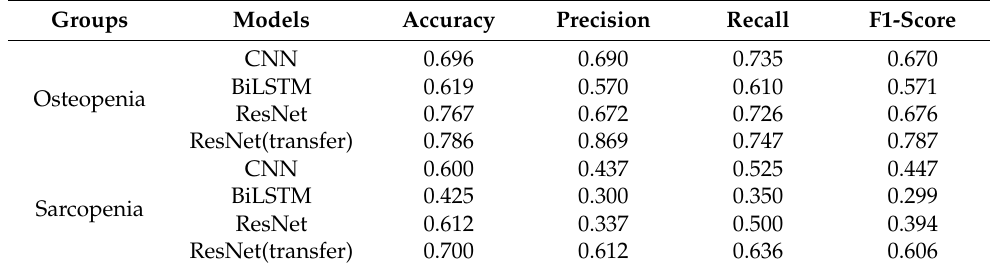
Table 6. Identification result of CNN, BiLSTM, and ResNet (accuracy, precision, recall and F1-score).